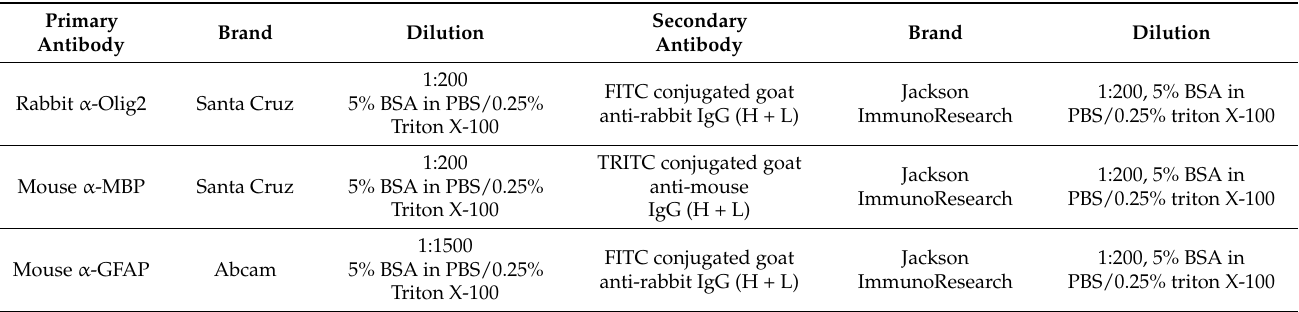
Table 3. Immunofluorescence